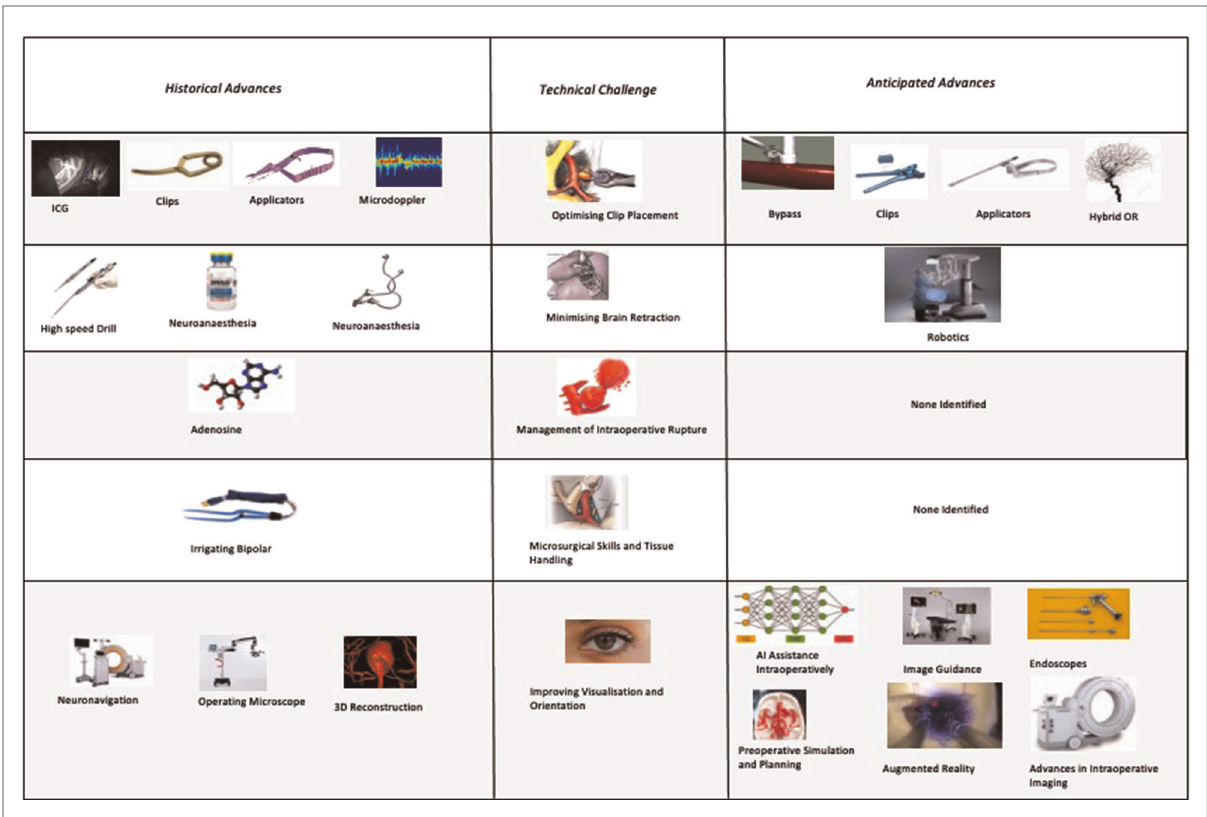
FIGURE 7 Anticipated advances in cerebral aneurysm surgery grouped by technical challenge (percentages do not sum to 100% as they express the proportion of respondents citing each